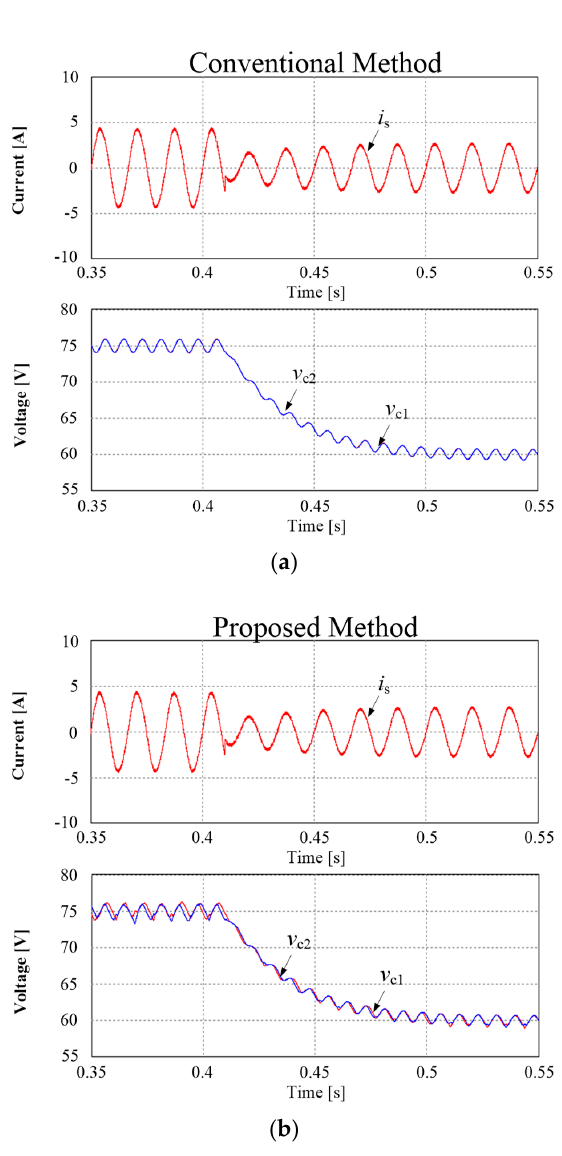
Figure 12. Simulation results of capacitor voltages ( v c1 , v c2 ) and source current with step change of dc voltage from 150 V to 120 V obtained by ( a ) conventional method and ( b ) proposed method.